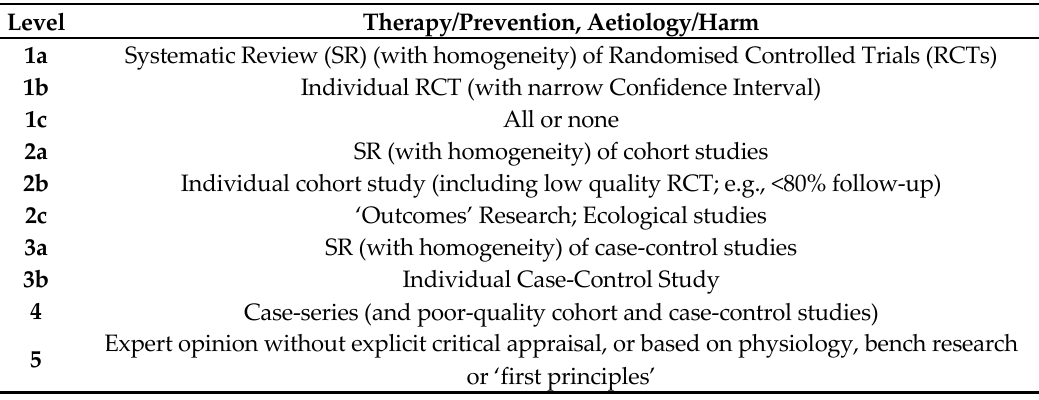
Figure 1. The Oxford Centre for Evidence-Based Medicine (OCEBM) 2009 Levels of Evidence (adapted from www.cebm.net) [23].